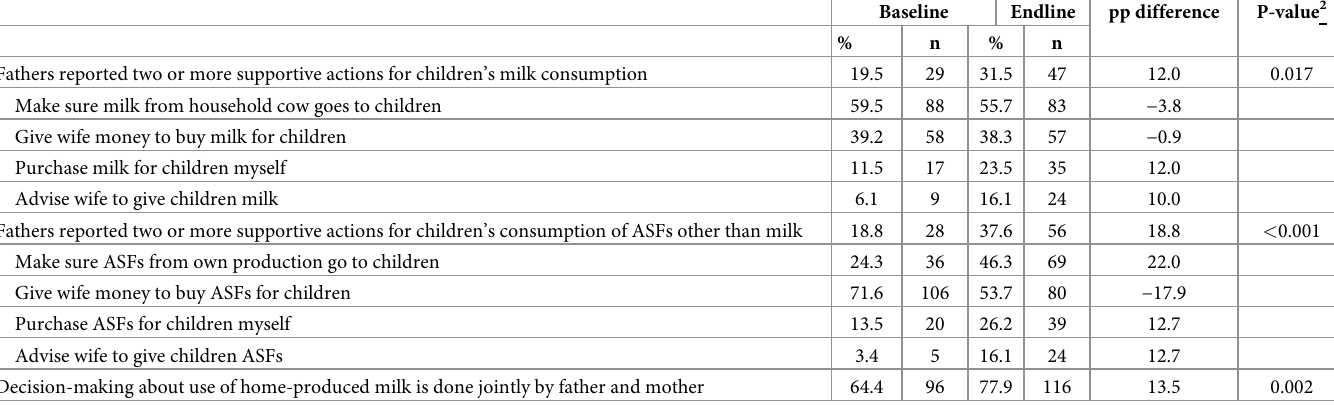
Table 4. Fathers’ support for milk and ASF consumption by children and household decision-making about use of home-produced milk (N = 149) 1 .